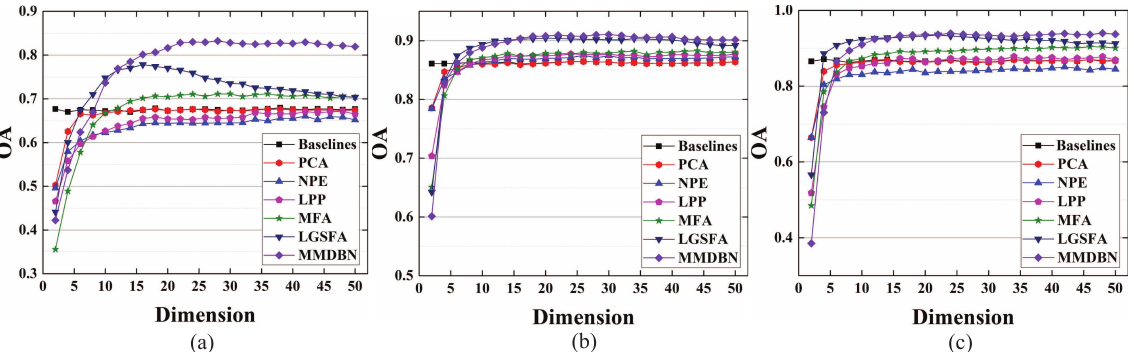
Figure 8. Classification results of MMDBN with different dimensions on the ( a ) Indian Pines, ( b ) Sali- nas, and ( c ) Botswana datasets.